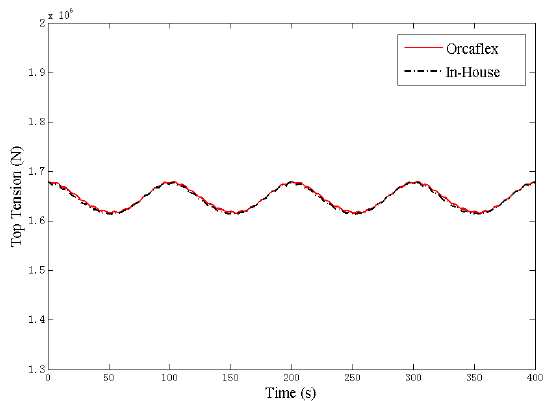
Figure 7. Single mooring line under horizontal harmonic excitation with wave and current.